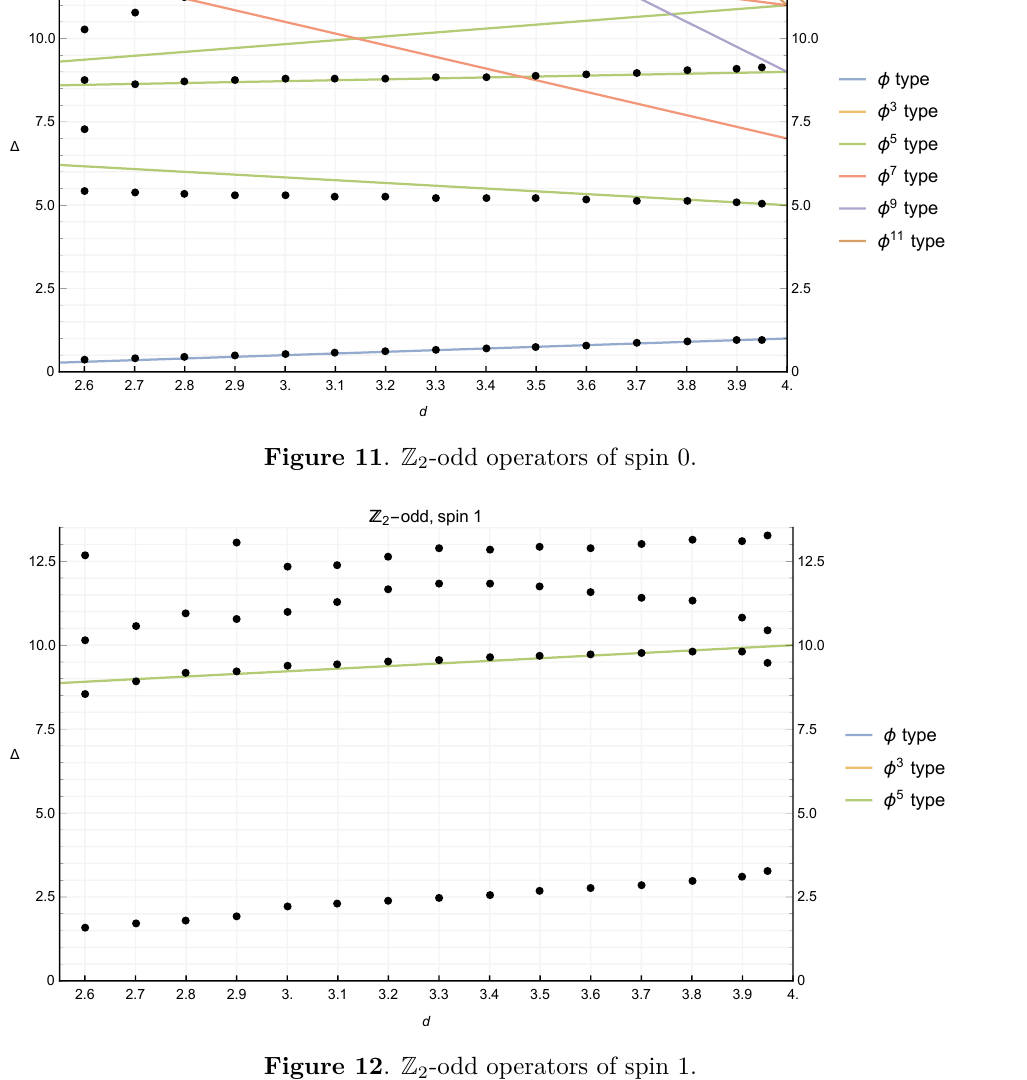
Figure 12 . Z 2 -odd operators of spin